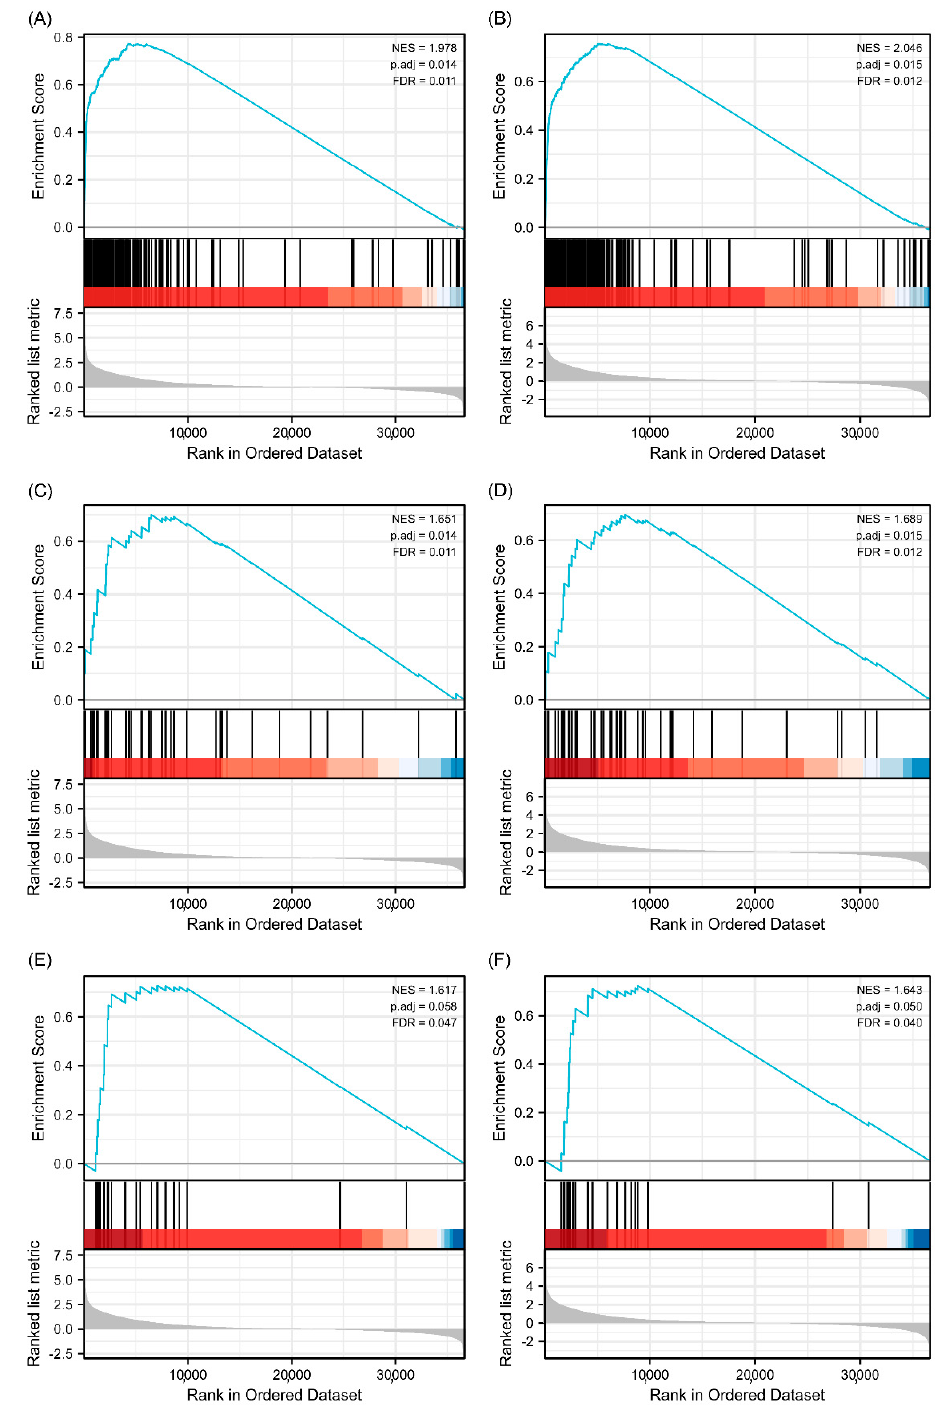
Figure 9. Enrichment plots from gene enrichment analysis (GSEA). ( A ) GSEA analysis for TPM3: immunoregulatory interactions between a lymphoid and a non-lymphoid cell. ( B ) GSEA analysis for TPM4: immunoregulatory interactions between a lymphoid and a non-lymphoid cell. ( C ) GSEA analysis for TPM3: interactions between immune cells and microRNAs in tumor microenvironment. ( D ) GSEA analysis for TPM4: interactions between immune cells and microRNAs in tumor microen- vironment. ( E ) GSEA analysis for TPM3: cancer immunotherapy by PD1 blockade. ( F ) GSEA analysis for TPM4: cancer immunotherapy by PD1